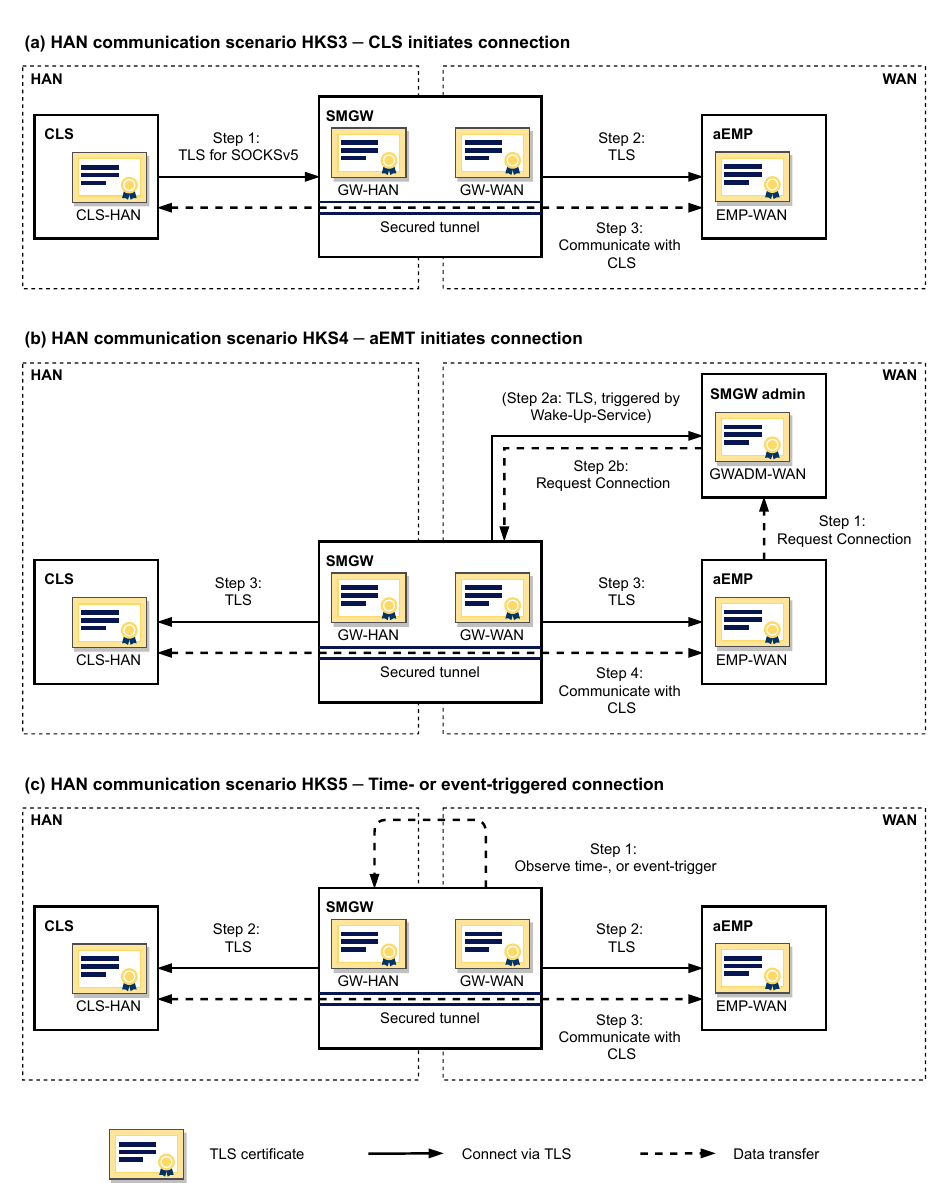
Figure 2. The three relevant HAN communication scenarios for integrating a decentralized energy management system (EMS), based on [6]. The major difference lies in who initiates the secured communication via the transparent